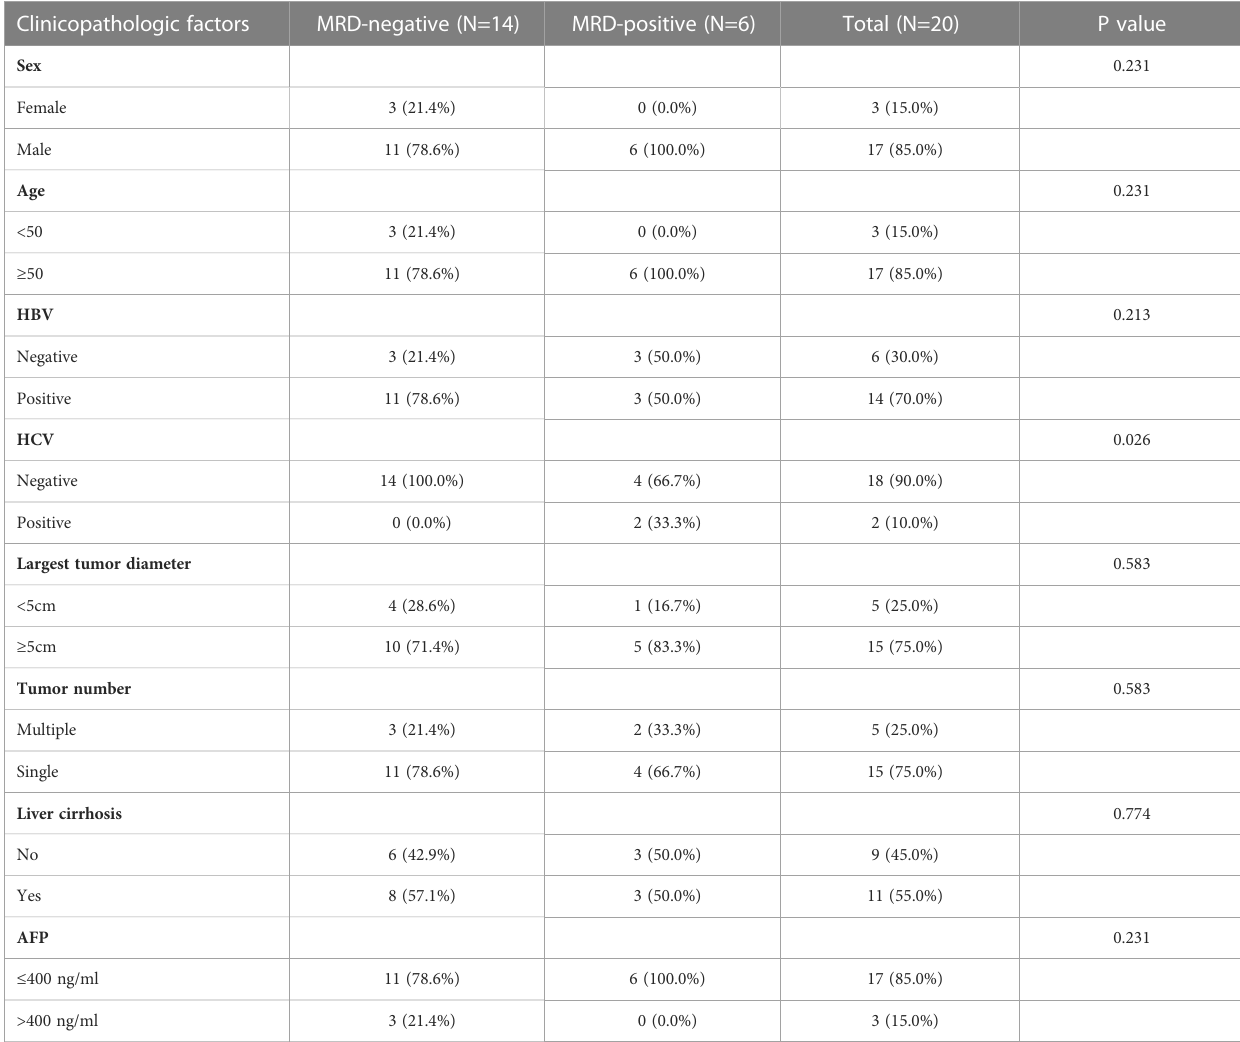
TABLE 1 Basic characteristics of HCC patients in the ZJZS2020